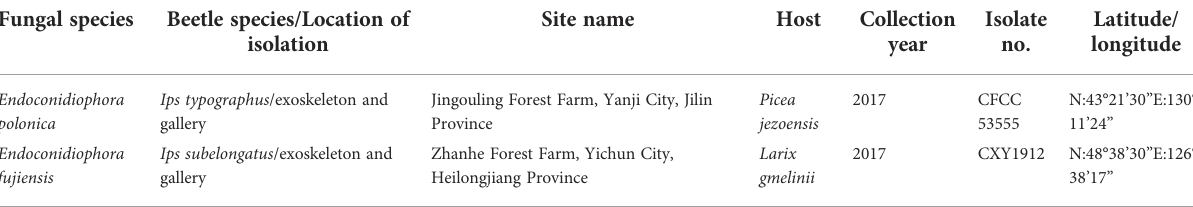
TABLE 2 Detailed source information on two Endoconidiophora fungi used in tree inoculations. Fungal